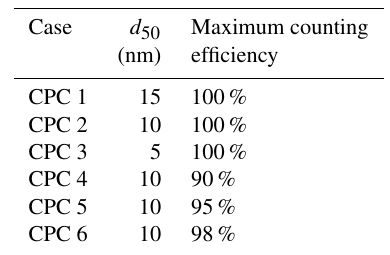
Table 3. Values of 50% cutoff diameter and maximum counting efficiency used in investigating κ app artifacts for low particle con- centrations measured by a